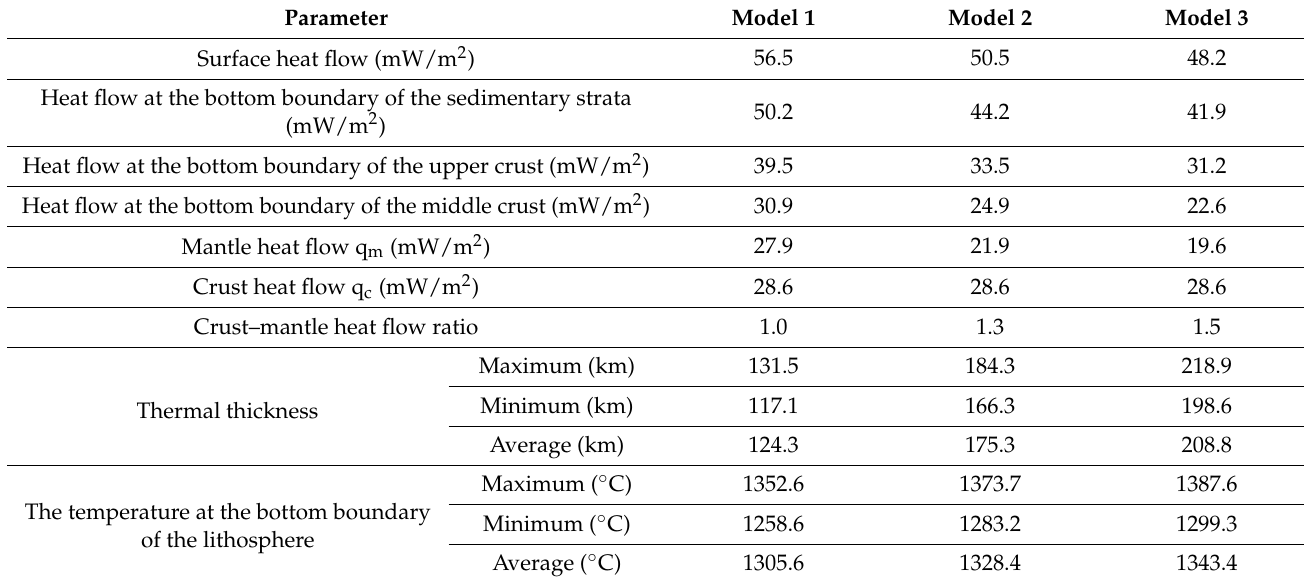
Table 5. Crustal layered structure and characteristics of thermal structure for different